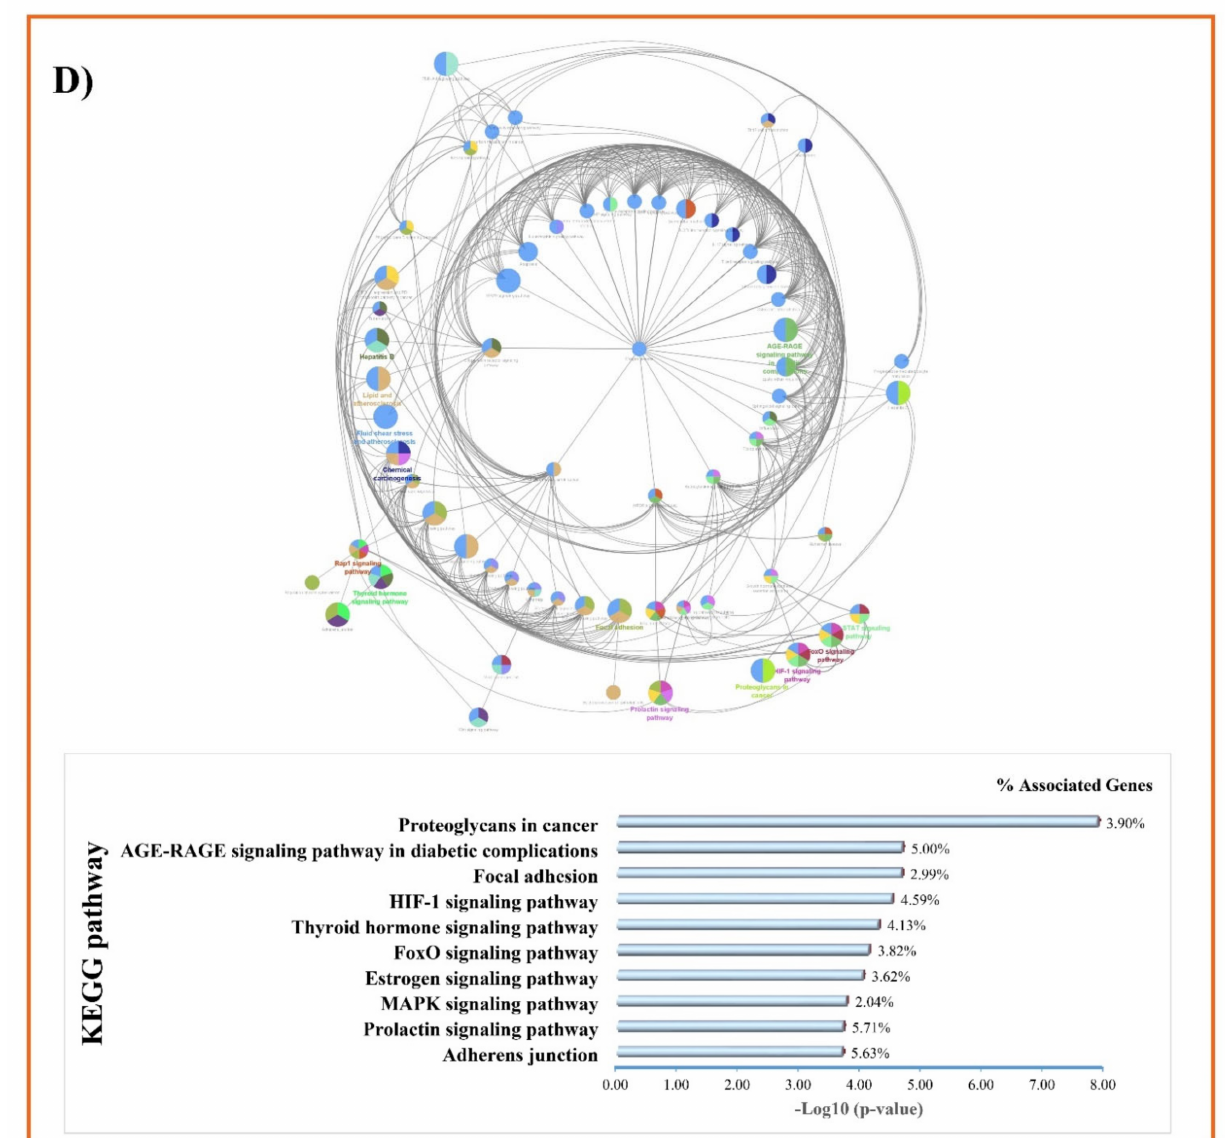
Figure 8. Gene Ontology enrichment analysis of the 13 shared protein targets (hub associated with liver cirrhosis ∩ curcumin targets) using ClueGO. ( A ) The ten highest adjusted p -value biological process; ( B ) the ten highest adjusted p -value molecular function; ( C ) the ten highest adjusted p -value cellular compound; ( D ) the ten highest adjusted p -value biological pathway (KEGG pathway) enrich- ment. Associated genes % indicates the percentage of gene sets present in each functional term. For example, if 50 genes are involved in a pathway, and ten genes of our gene set are involved in this pathway, the associated genes % equals